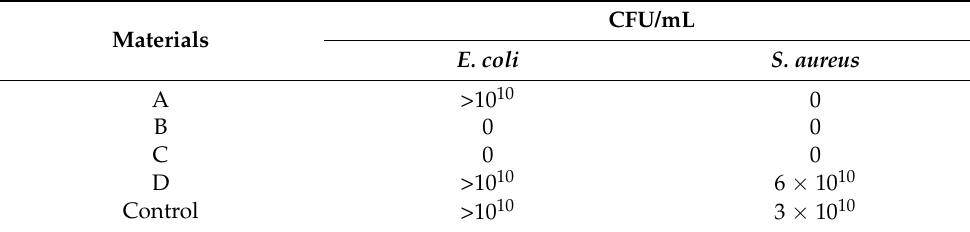
Figure 2. SEM micrographs showing the presence of the Gr-Ag (5 wt% Ag) hybrid (marked with *) attached to the HEPA filters ( a – c ), compared to the control filter ( d ) treated only with ethanol. Table 1. The colony forming units (CFU/mL) method indicating the bactericidal/bacteriostatic effect of the HEPA filter treated with different concentrations of Gr-Ag (5 wt% Ag) hybrid .